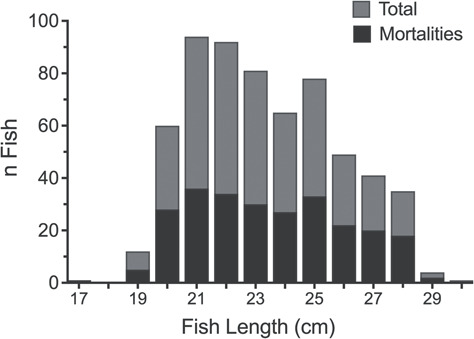
Length distribution of total catch (grey bars) and mortalities (black bars) of black sea bass discard captures within commercial traps and two research sites (n = 675)